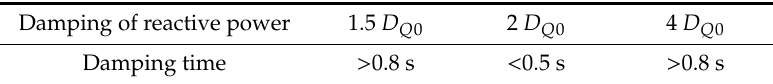
Table A1. Parameters of DFIG and VSG Control.